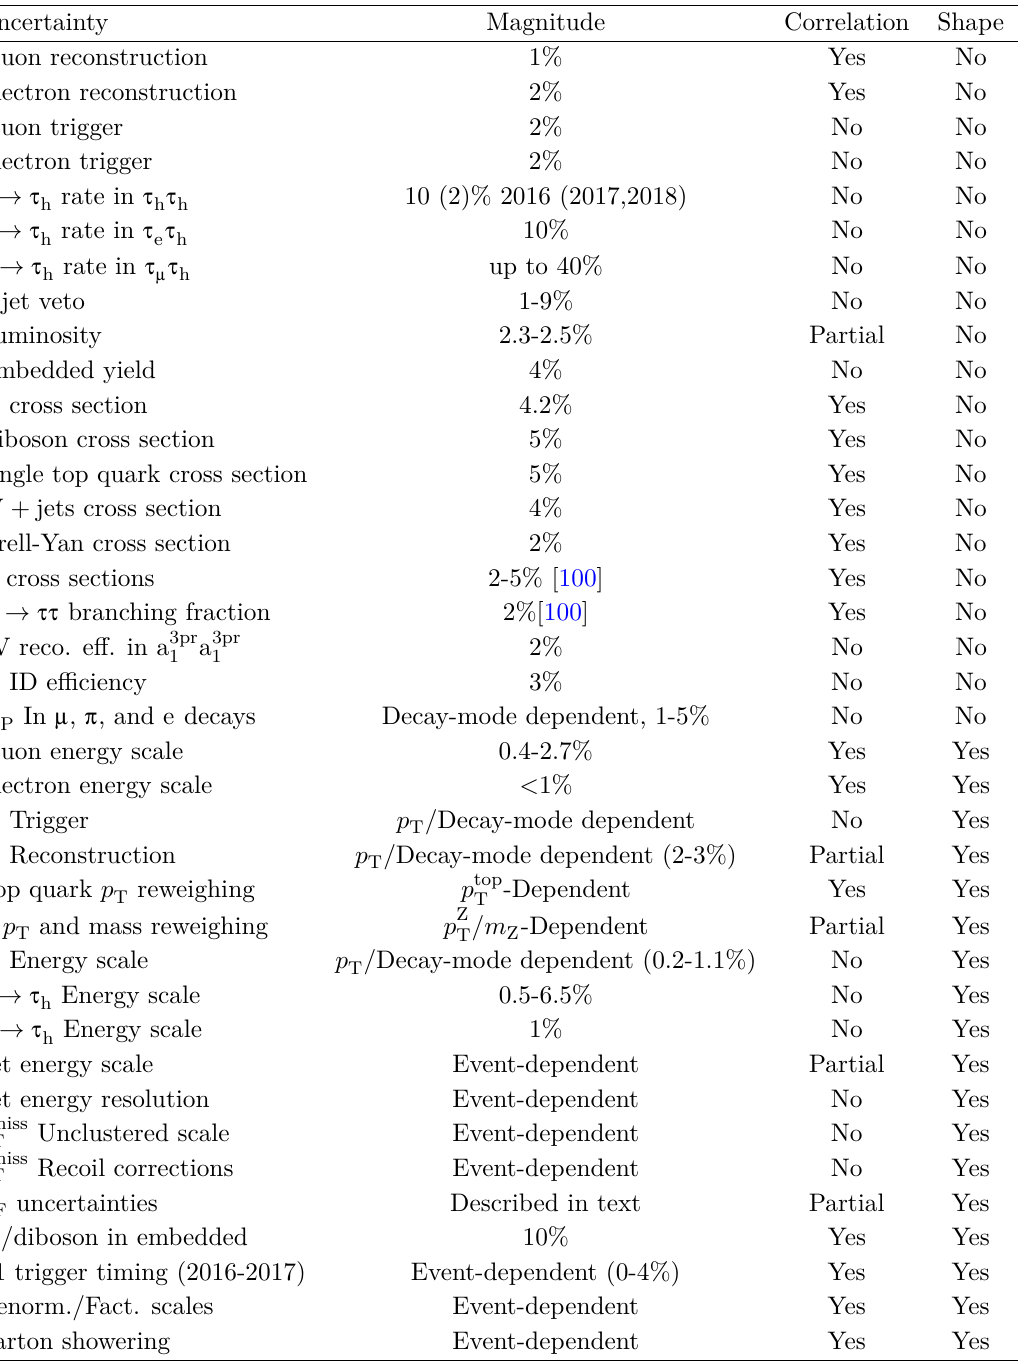
Table 6 . Overview of the systematic uncertainties. The third column indicates if the source of uncertainty was treated as being correlated between the years in the fit described in section 12. The fourth column indicates if the uncertainty affects the shapes of the